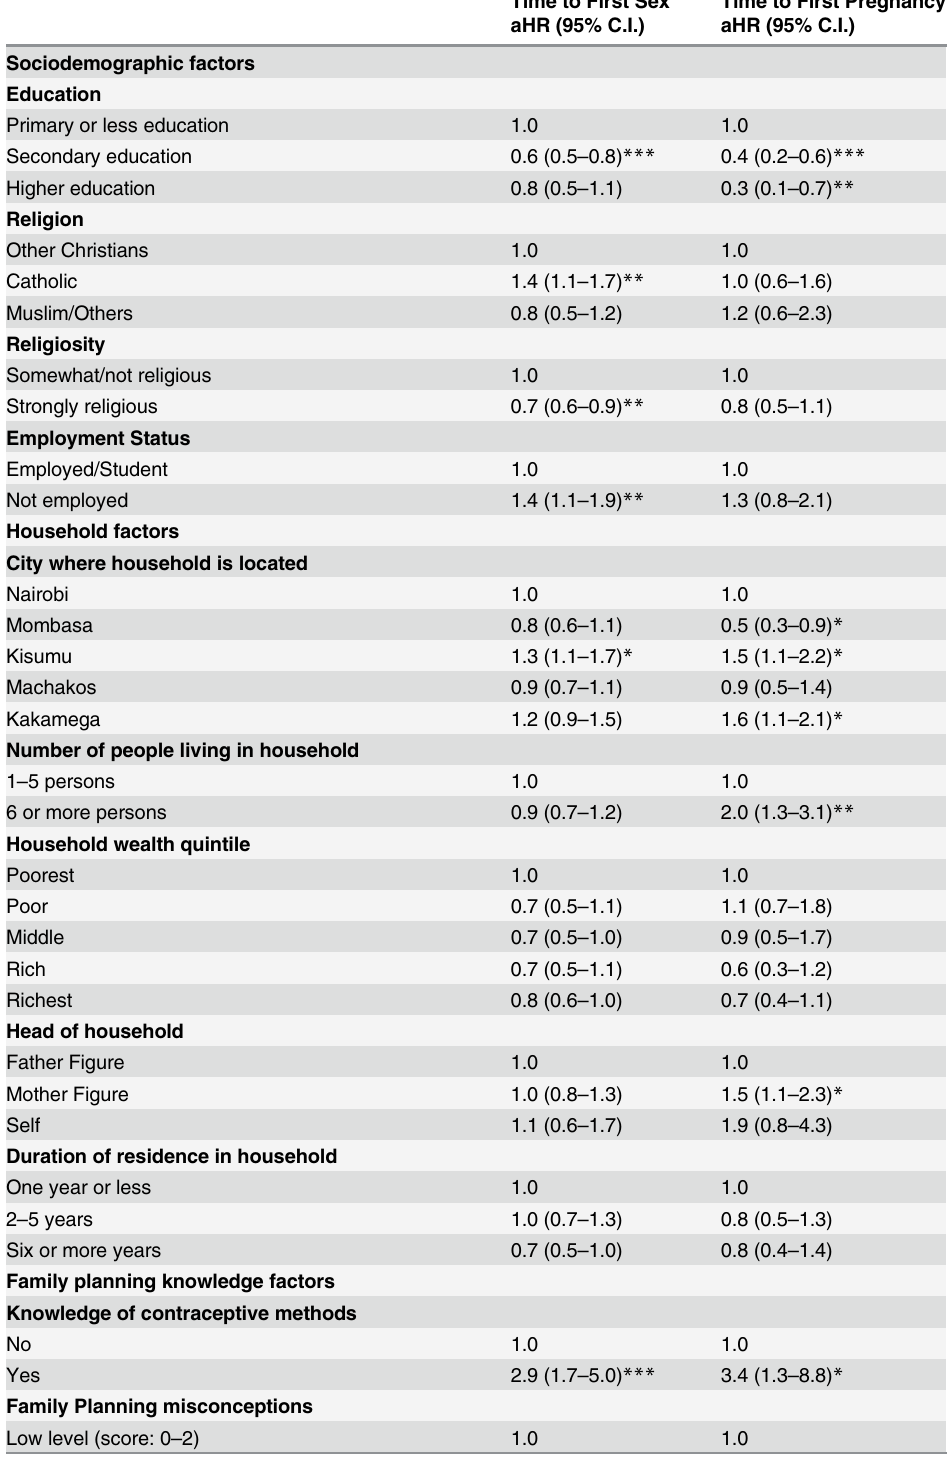
Table 4. Cox regression (hazard ratios) of timing of first sex and first pregnancy among never-married females aged 15 – 24 years in urban Kenya (weighted n = 2020). Time to First Sex Time to First Pregnancy aHR (95% C.I.) aHR (95%